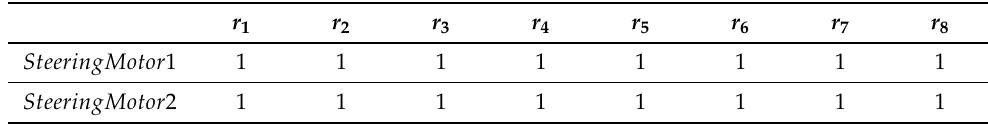
Figure 12. Symptoms changing trend when steering motor fails at 104 s. Table 2. Fault–symptom relationships of r 1 to r 8 for condition monitoring of actuators of the steering system (case